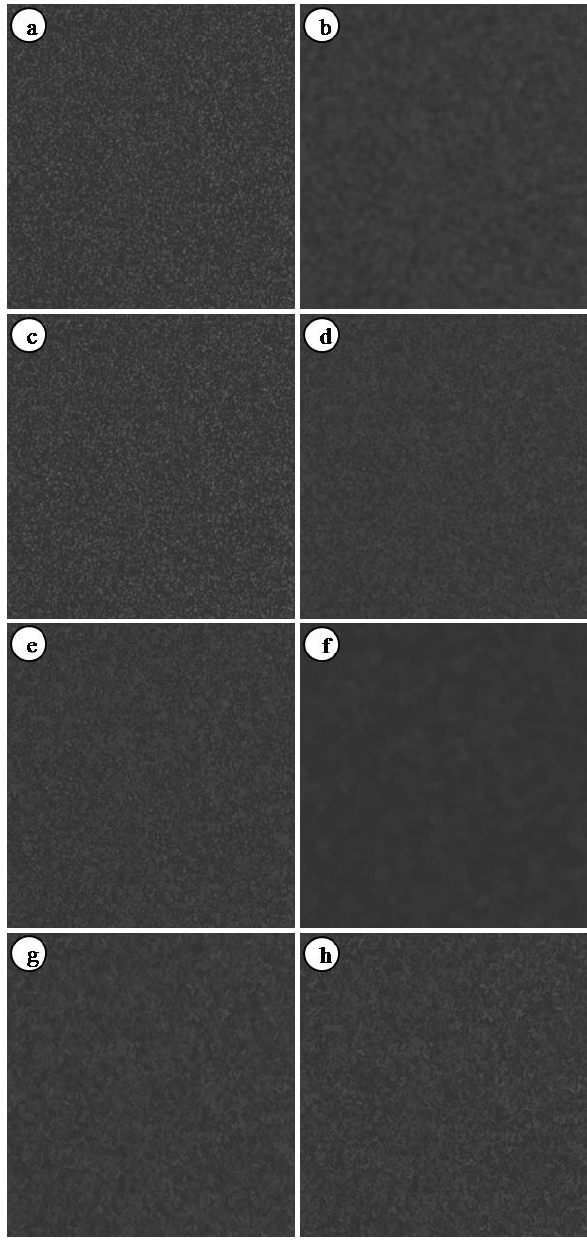
Figure 7. A homogenous water area; a) the original Radarsat-2 image and the results of its filtration, using: b) Median filter, c) Frost filter, d) Lee-sigma filter, e) Gamma-MAP filter, f) SAF, g) MSE filter, h) MSE filter by reconstruction; filter window